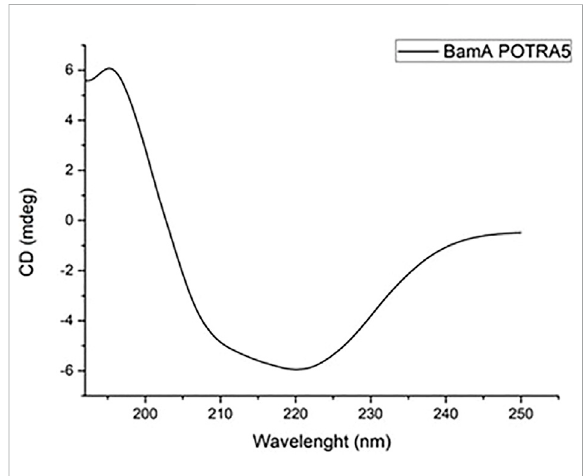
FIGURE 3 CD spectrum of 0.2 mg mL − 1 BamA p5 protein in 20 mM Tris- HCl pH 8.4 buffer.